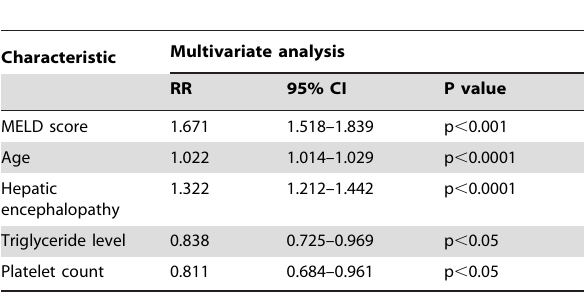
Table 5. Candidate variables for survival predicting through multivariate analysis.